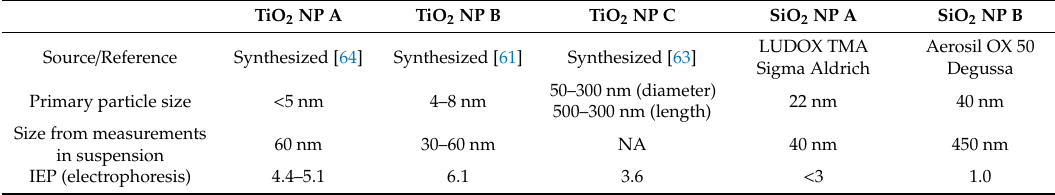
Table 1. Properties of the nanoparticles used in the present